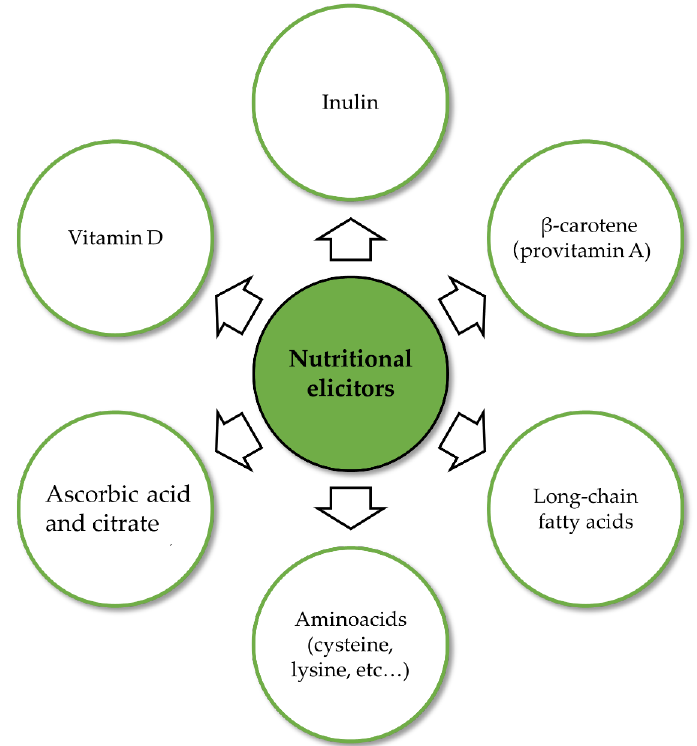
Figure 5. Elicitors for human essential elements intake.